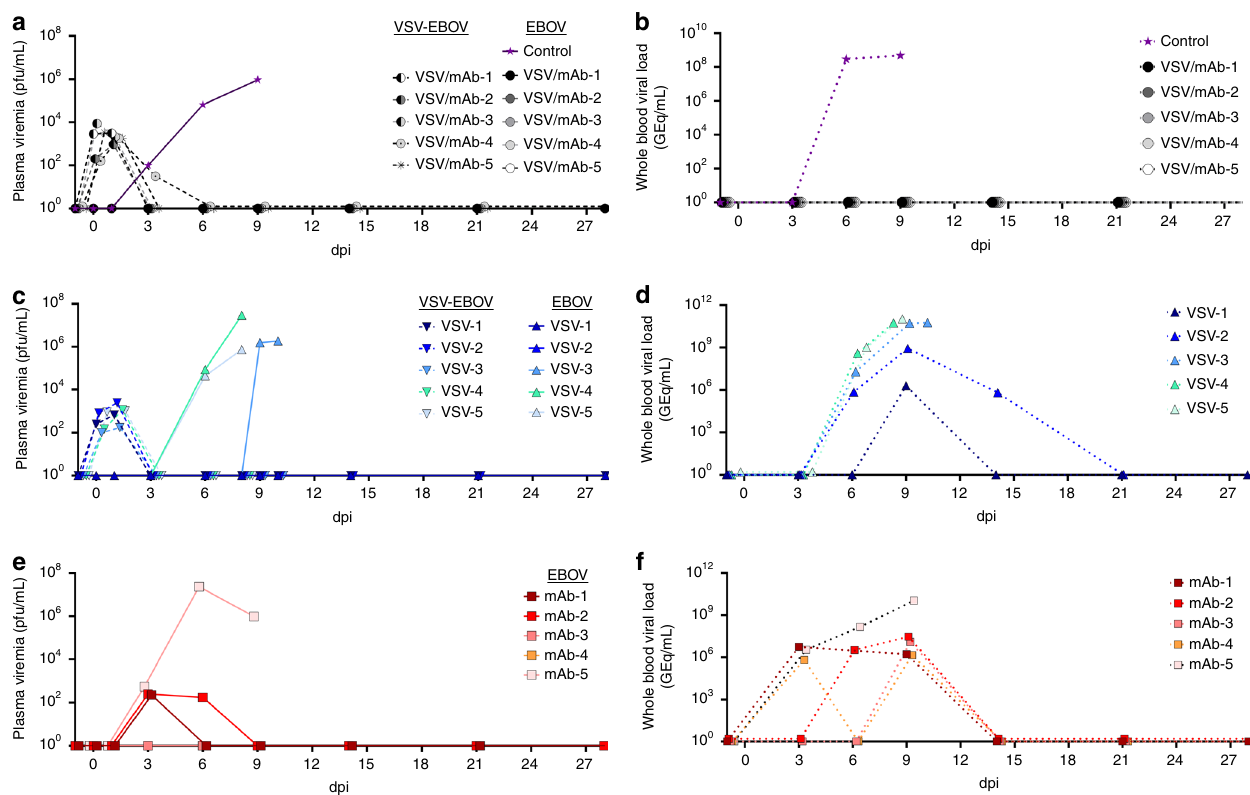
Fig. 3 Circulating infectious virus and vRNA. Plasma viremia and vRNA content in whole blood of rVSV-ZEBOV + MIL77 ( a , b ), rVSV-ZEBOV ( c , d ), and MIL77 ( e , f ). Limit of detection for infectious virus assays was 25 pfu/ml. Source data are provided as a Source data fi